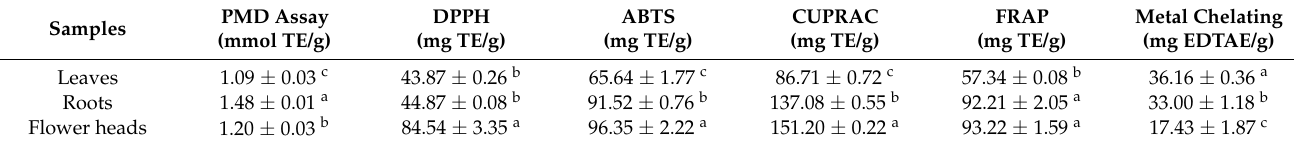
Table 3. Antioxidant activity of the T. balsamita extracts.